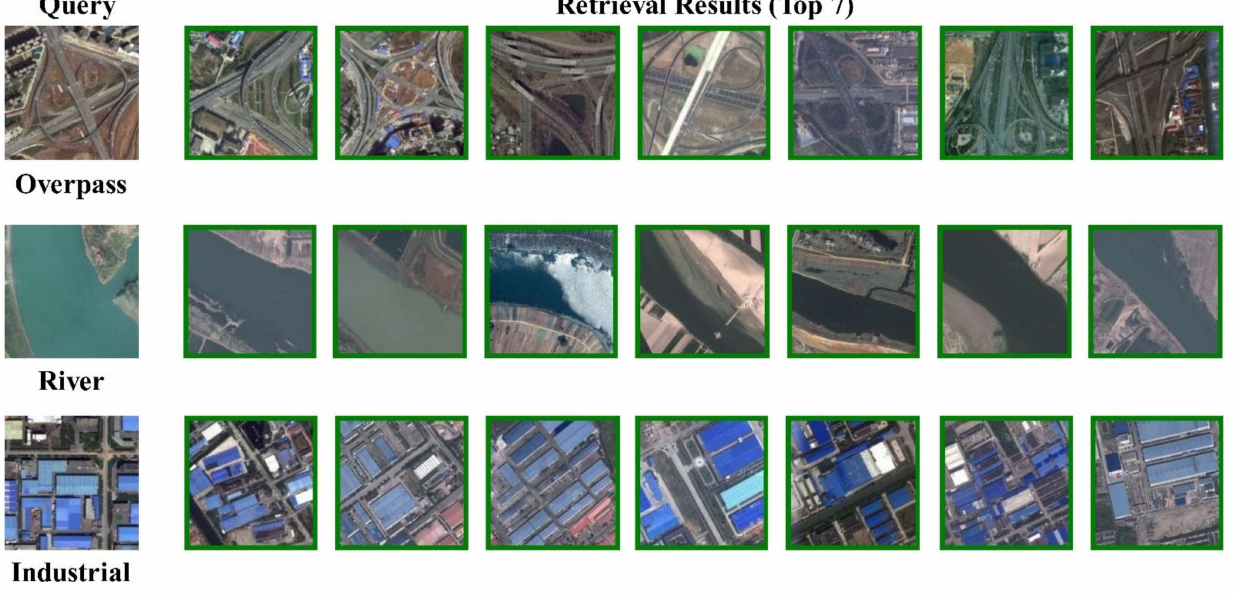
Figure 5. Examples of the retrieval results on SIRI-WHU. Each row corresponds to a test case: the query is shown in the first column, and the second to fifth columns are the retrieval results ranked from 1 to 8. For each dataset, the first row represents the results derived from our method, and the second to sixth rows are the results from DCES, BIER, A-BIER, and